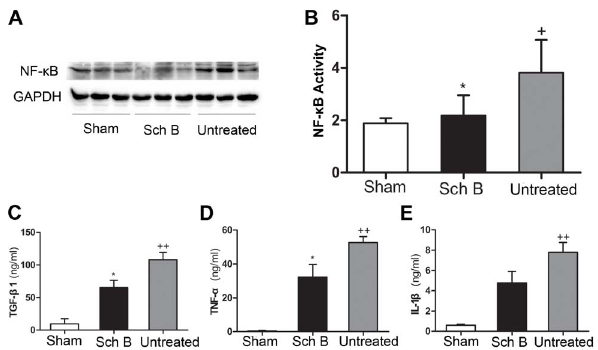
Figure 4. Sch B in the effects of expression of inflammation cytokines after MI. (A) Western blot analysis of NF- k B. GAPDH was used as an internal control. (B) Densitometry for NF- k B expression normalized to GAPDH. (C) Quantitative analysis of TGF- b 1 expression of LV myocardium by ELISA. (D) Quantitative analysis of TNF- a expression of LV myocardium by ELISA. (E) Quantitative analysis of IL-1 b expression of LV myocardium by ELISA. n=8 per group, * P , 0.05 versus untreated group, + P , 0.05 versus sham-operated group, ++ P , 0.01 versus sham- operated group.